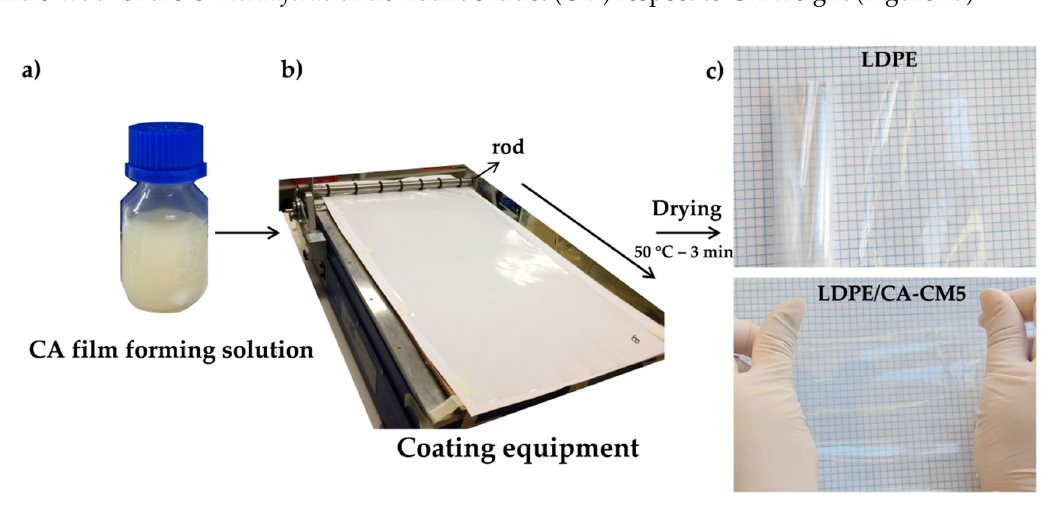
Figure 2. Schematic representation of the bi-layer film-forming process: ( a ) film coating solution, ( b ) coating application over LDPE film followed by drying process, and ( c ) visual appearance of the CA-CM coated LDPE films.